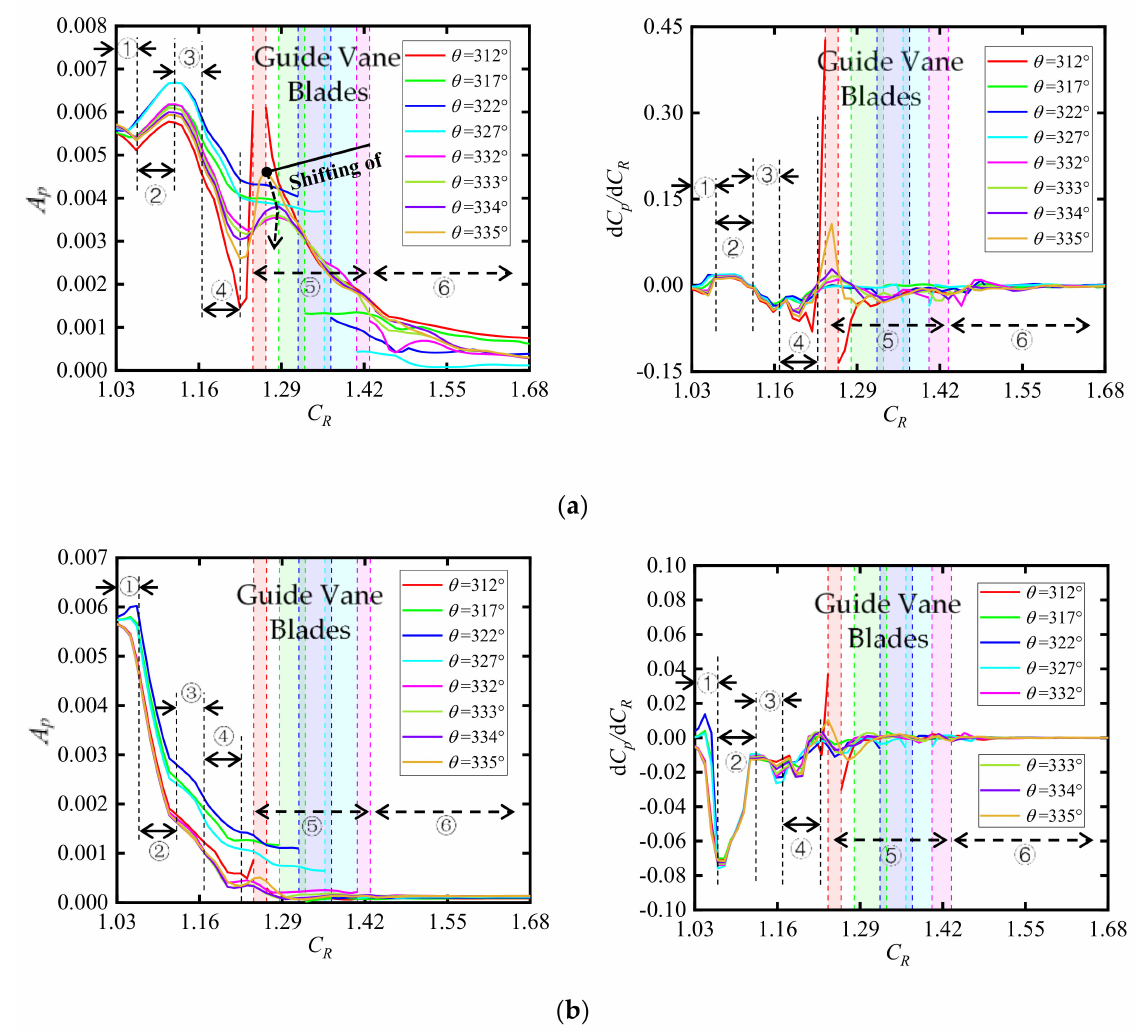
Figure 18. Radial amplitude of A p distribution. ( a ) 140 Hz; ( b ) 280 Hz; 1 (cid:13) impeller blade trailing-edge downstream region; 2 (cid:13) amplitude fluctuation region; 3 (cid:13) vaneless attenuation region; 4 (cid:13) pre-guide-vane fluctuating region; 5 (cid:13) inter-channel attenuation region; 6 (cid:13) post-guide-vane